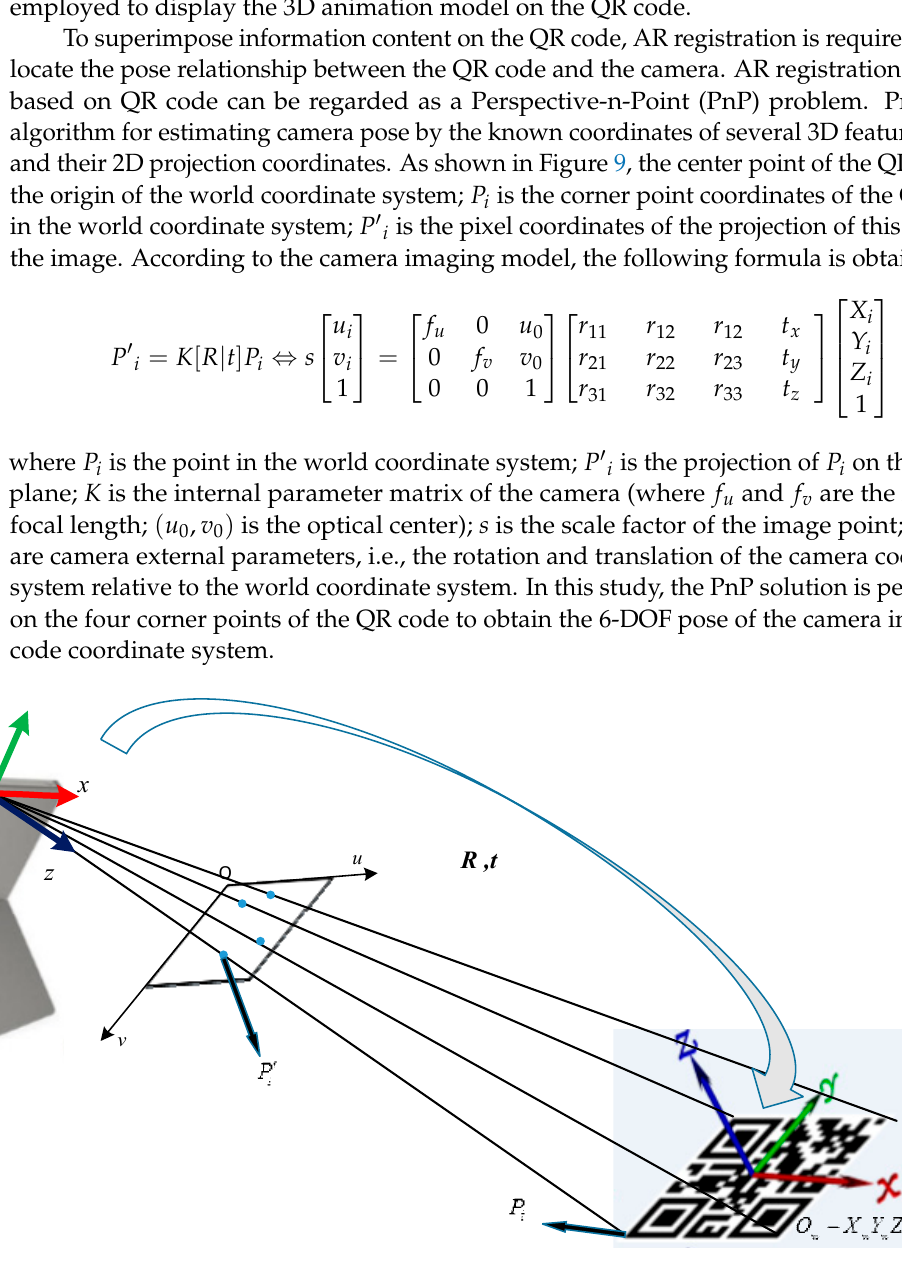
Figure 9. Schematic diagram of AR registration based on QR code.